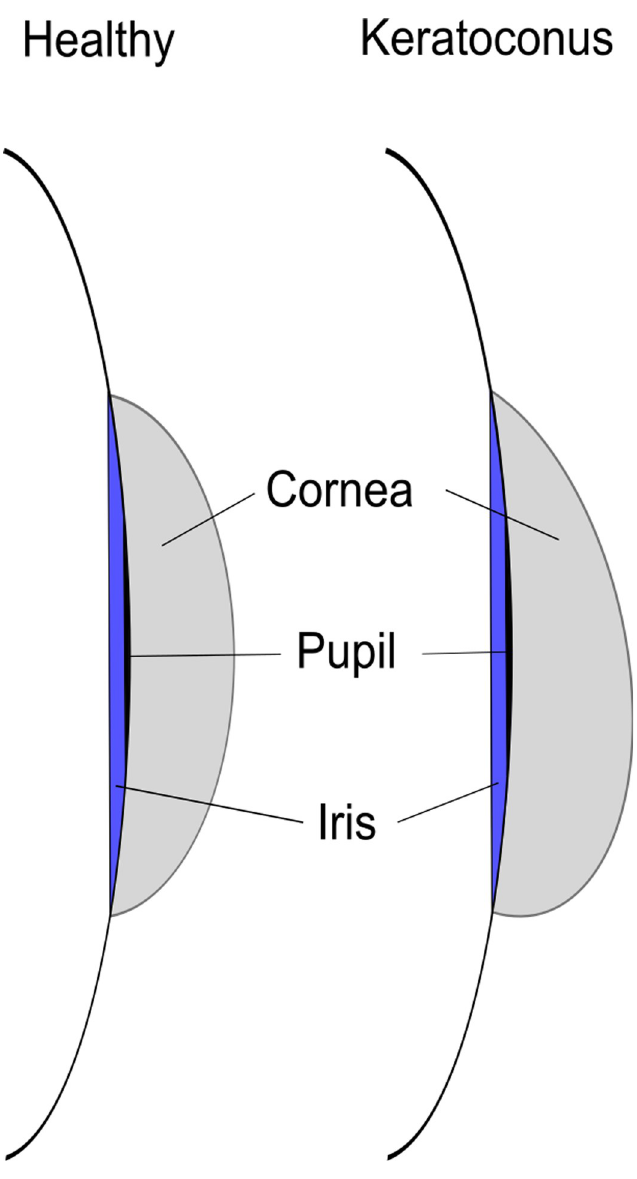
Fig 1. Schematic of a healthy eye and one with